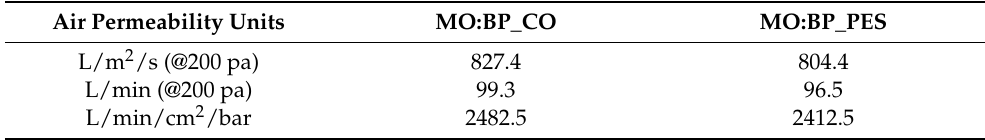
Table 2. Air permeability values of the cotton (CO) and polyester (PES) samples functionalized with methyl orange and bromocresol purple (MO:BP), converted into different